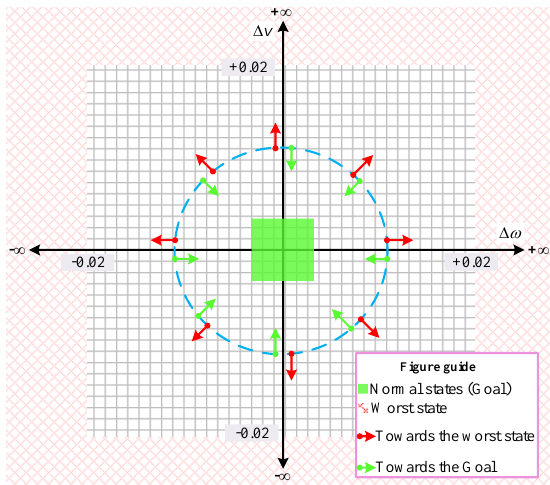
Figure 6. The two-dimensional perspective of the discrete environment of the proposed MDP model.